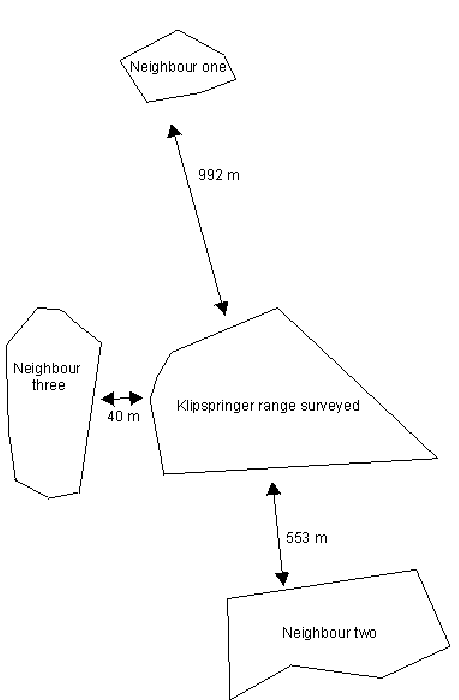
Fig. 1. Schematic presentation of a klipspringer range that was surveyed for scent marks, and the proximity of the nearest